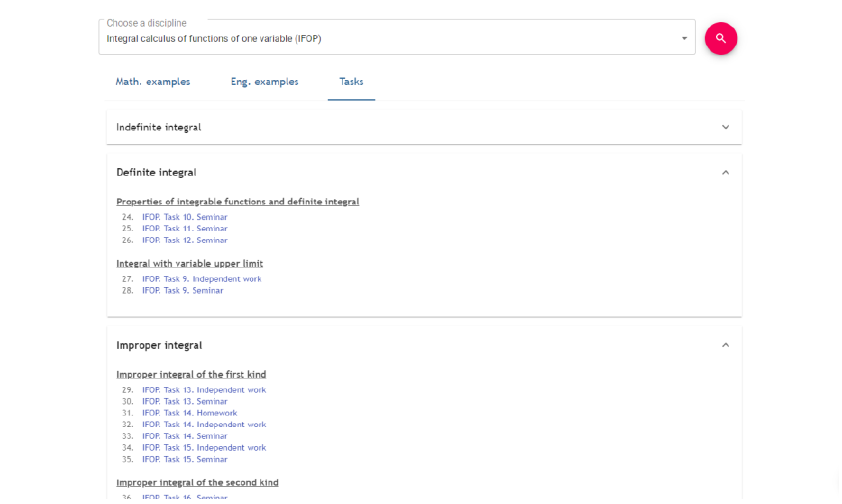
Fig. 4 Structure of practical lessons in the digital course